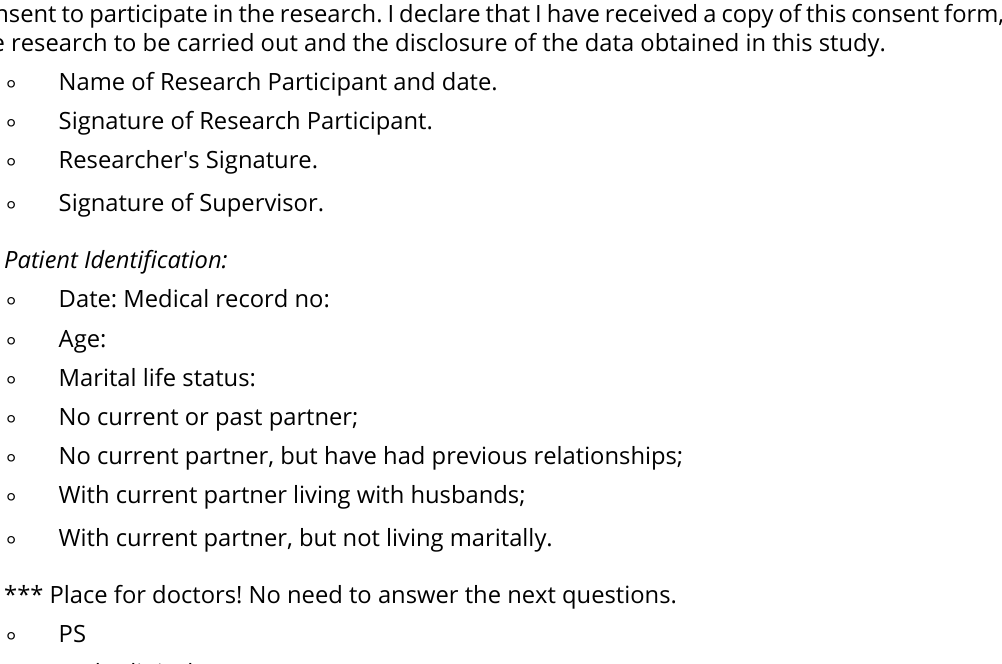
Title of Research: "Sexual aspects associated with women with breast cancer using hormone